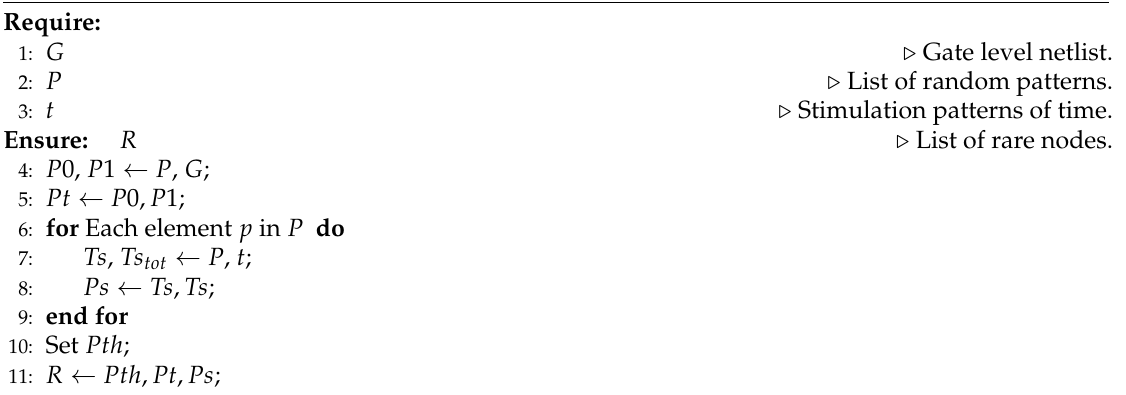
Algorithm 1 Key-gate location strategy based on rare nodes.